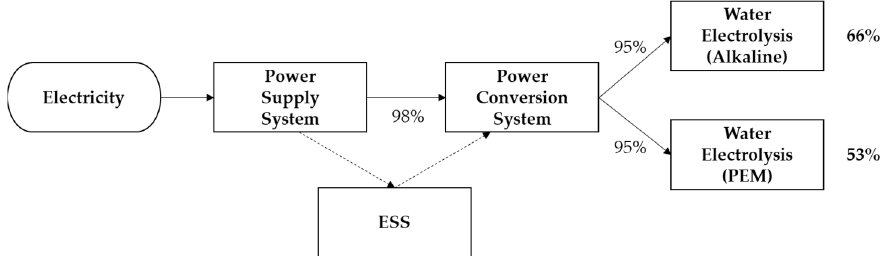
Figure 3. Cumulative efficiency of hydrogen production for each type of water electrolysis.